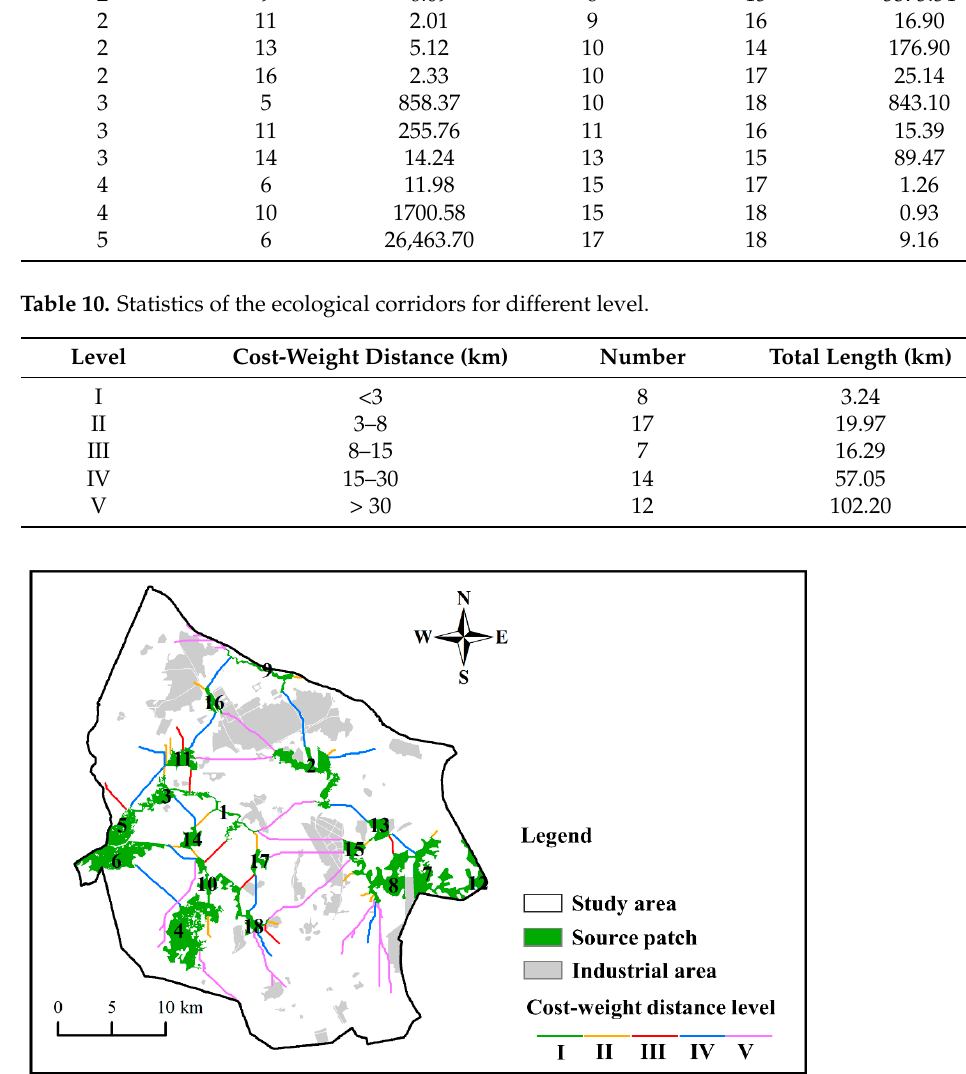
Figure 10. Distribution of the ecological corridors for different levels. Table 10. Statistics of the ecological corridors for different level.